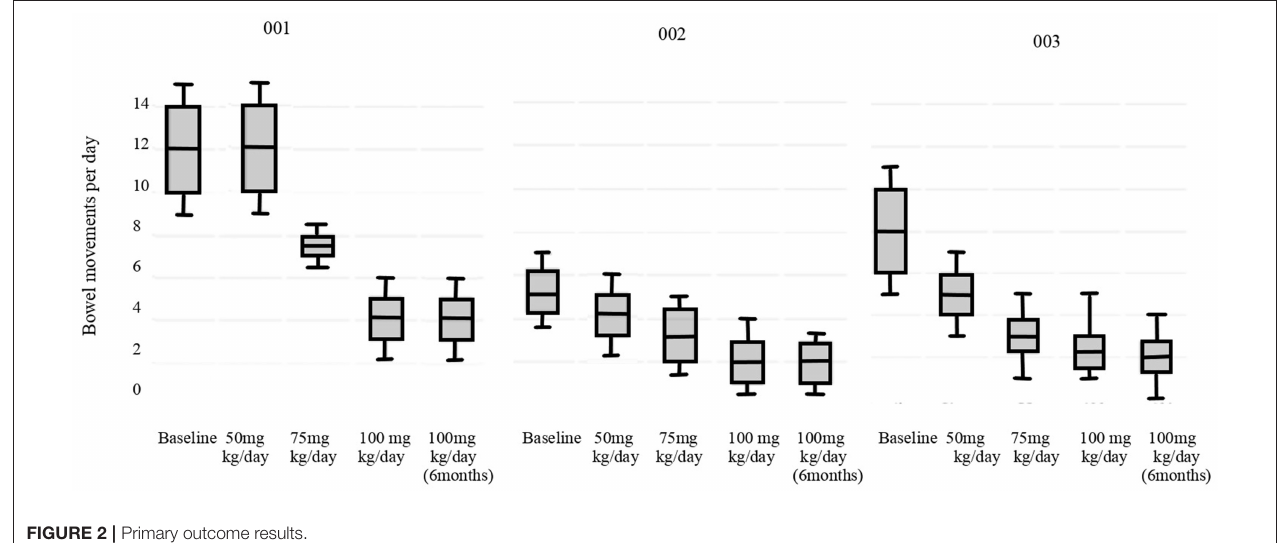
FIGURE 2 | Primary outcome results.